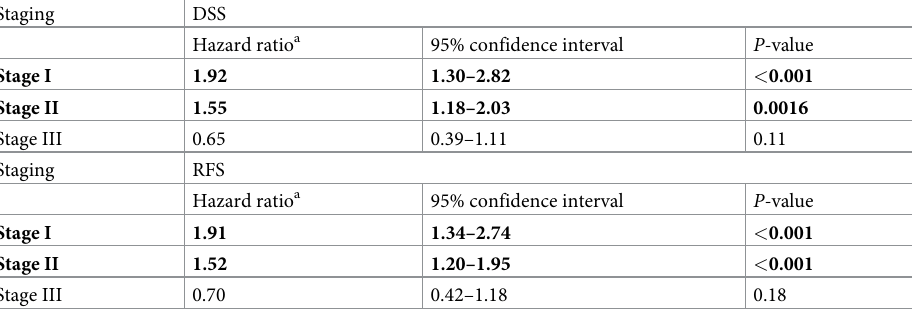
Table 1. Multivariate Cox regression analyses of disease-specific survival (DSS) and relapse-free status (RFS) in tumor stages I, II or